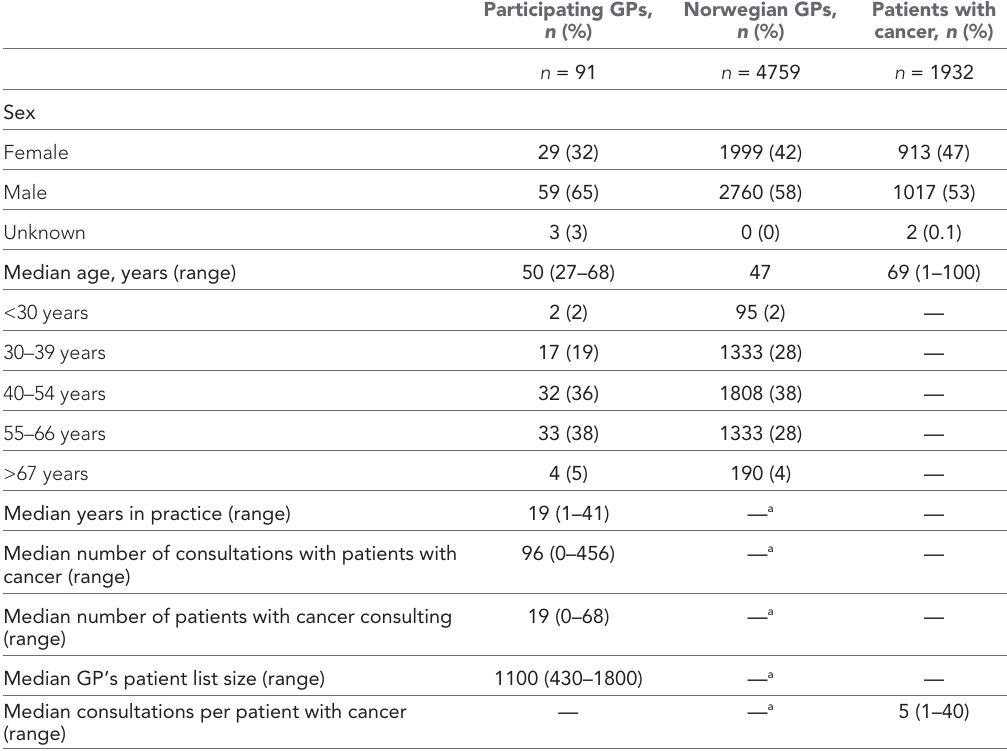
Table 1 Demographic characteristics of participating GPs, all Norwegian GPs, and included patients with cancer